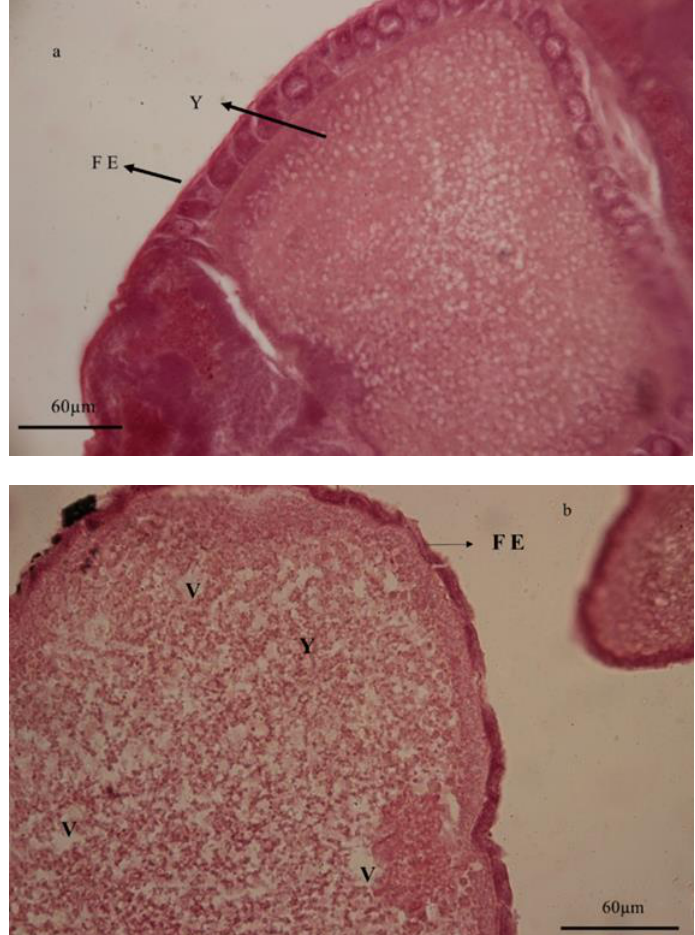
Figure 6. Histology of ovaries in adults of Glyphodes pyloalis emerging from untreated ( a ) and treated larvae by Artemisia annua floral essential oil ( b ). In treatments of the ovarian sheath significant changes and yolk granules were reduced under the influence of vacuolization in cytoplasm compared to the control . ( FE ) follicular epithelium, ( V ) vacuole, and ( Y ) yolk granules.